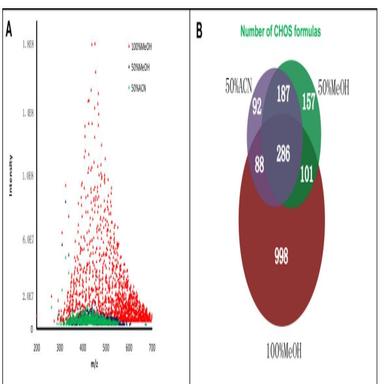
Comparison of the ion intensities of the CHOS-molecules (A) and the number of molecular formulas (B) obtained with different spray solvents observed by FTICR-MS with different spray solvents.